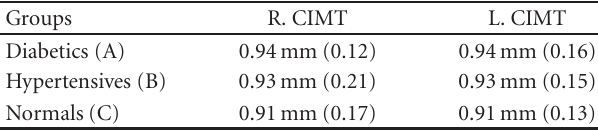
Table 1: Mean (SD) carotid intima media thickness in